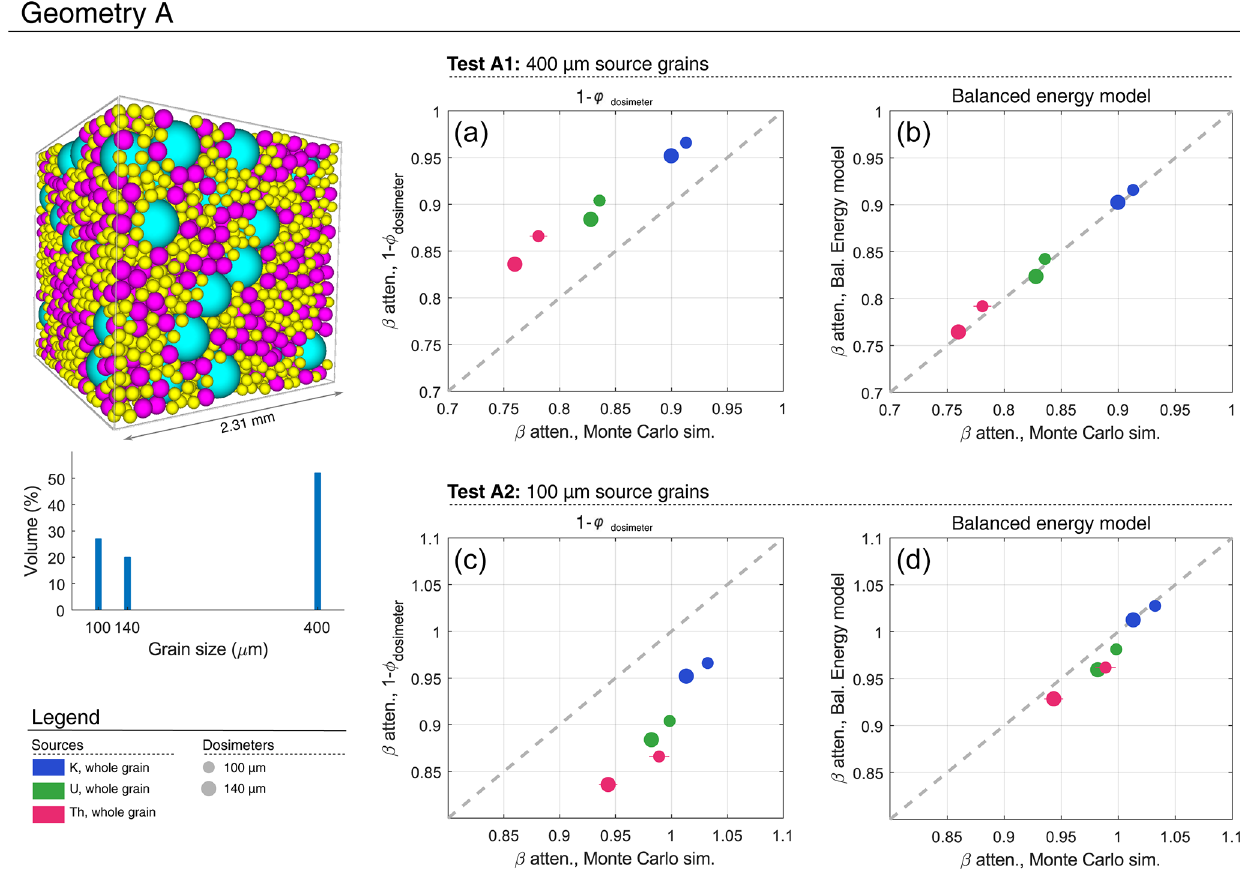
Figure 2. Testing beta attenuation models against Monte Carlo radiation transport simulations using MCNP6 with PackLSD geometry. Geometry configuration A is the geometrical model for two tests, A1 and A2, with an atypical grain-size distribution (colours used in the packing illustration are to help visualise grain sizes). In test A1, the source grains are all 400µm in diameter, with particles initiated homogenously throughout the grain (“whole grain”), calculated separately for 40 K, U-series, and Th-series sources. The mean attenuation factor is shown for 100 and 140µm dosimeters and compared against (a) 1 − ϕ dosimeter and the (b) Balanced Energy Model. Test A2 shows equivalent results in (c) and (d) when sources are all 100µm